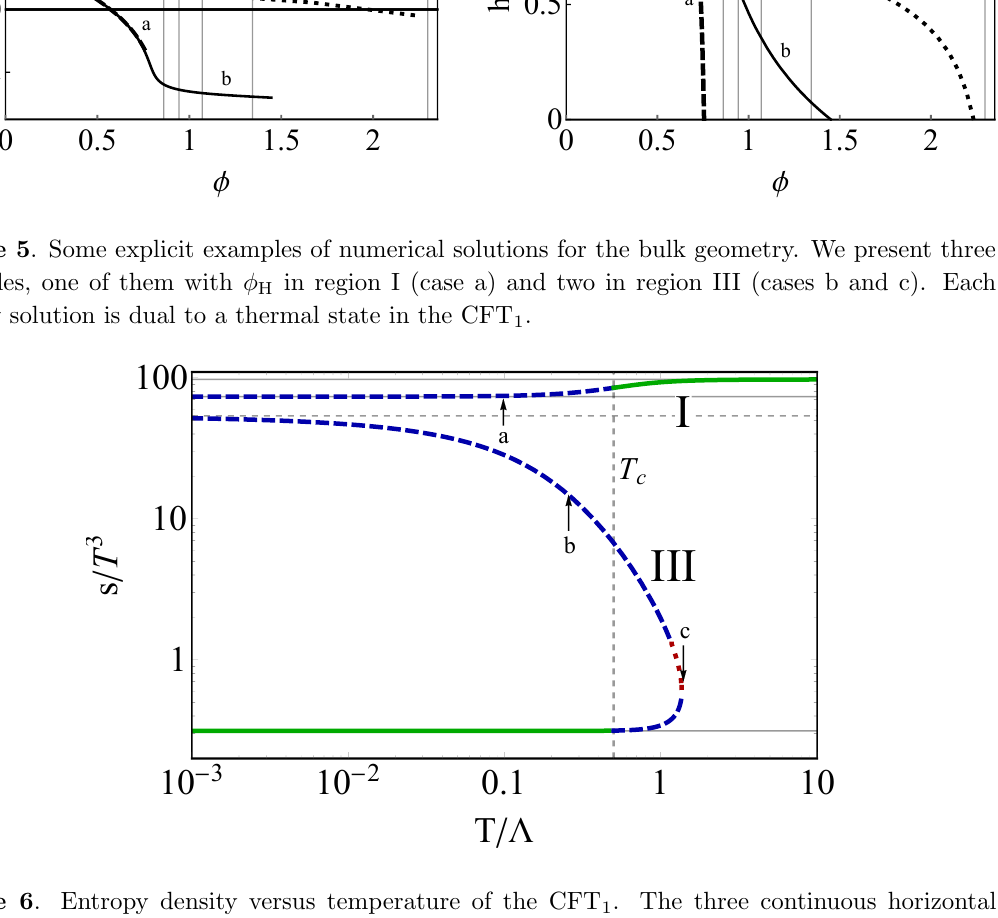
Figure 6 . Entropy density versus temperature of the CFT 1 . The three continuous horizontal lines correspond to the entropy densities of Schwarzschild-AdS solutions with (from top to bottom) (cid:30) = (cid:30) 1 , (cid:30) = (cid:30) 2 and (cid:30) = (cid:30) 4 . The dashed horizontal line corresponds to the thermal branch of the CFT 2 with non-vanishing VEV. The vertical dashed line is the phase transition temperature T c = (cid:3) = 0 : 499. The labels \a", \b" and \c" indicate the thermal states dual to the gravity solutions presented in (cid:12)gure